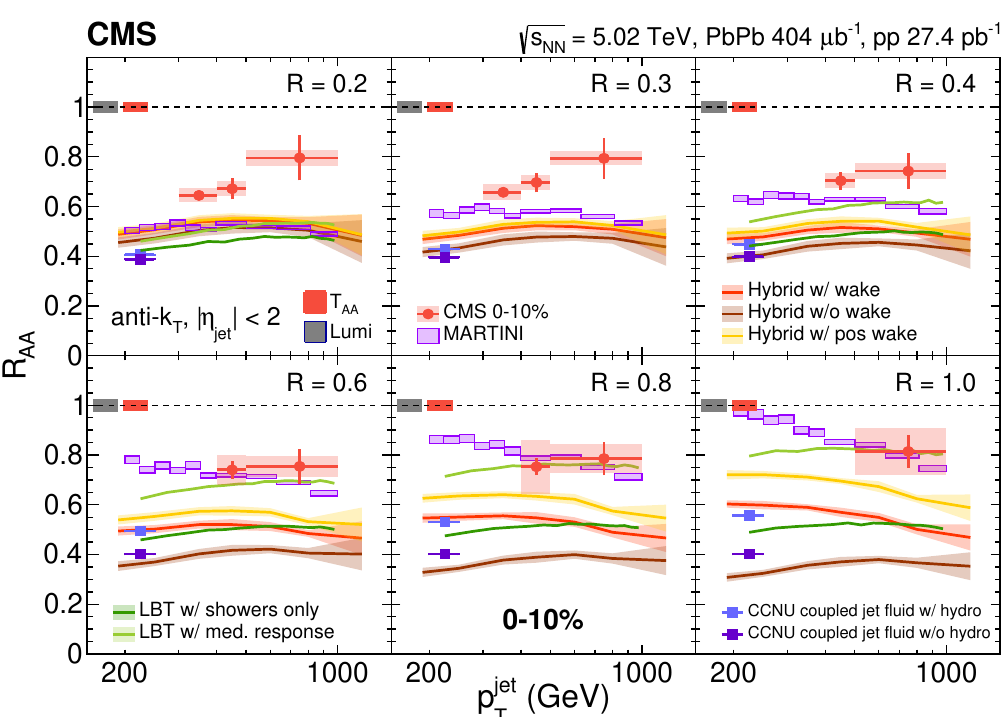
for jets with | η jet | < 2 . 0 , as a function of p jet , for various R values and Figure 11 . The R AA T the 0–10% centrality class. The statistical uncertainties are represented by vertical lines, while the systematic uncertainties are shown as shaded boxes. The markers are placed at the bin centers. Global uncertainties (integrated luminosity for pp and h T i for PbPb collisions) are shown as the AA colored boxes on the dashed line at R = 1 and are not included in the shaded bands around the AA points. The predictions from Hybrid (dark orange, brown and yellow), Martini (purple), lbt (lime and dark green), and Ccnu (blue and violet) models, shown as the colored boxes and bands, are compared to the